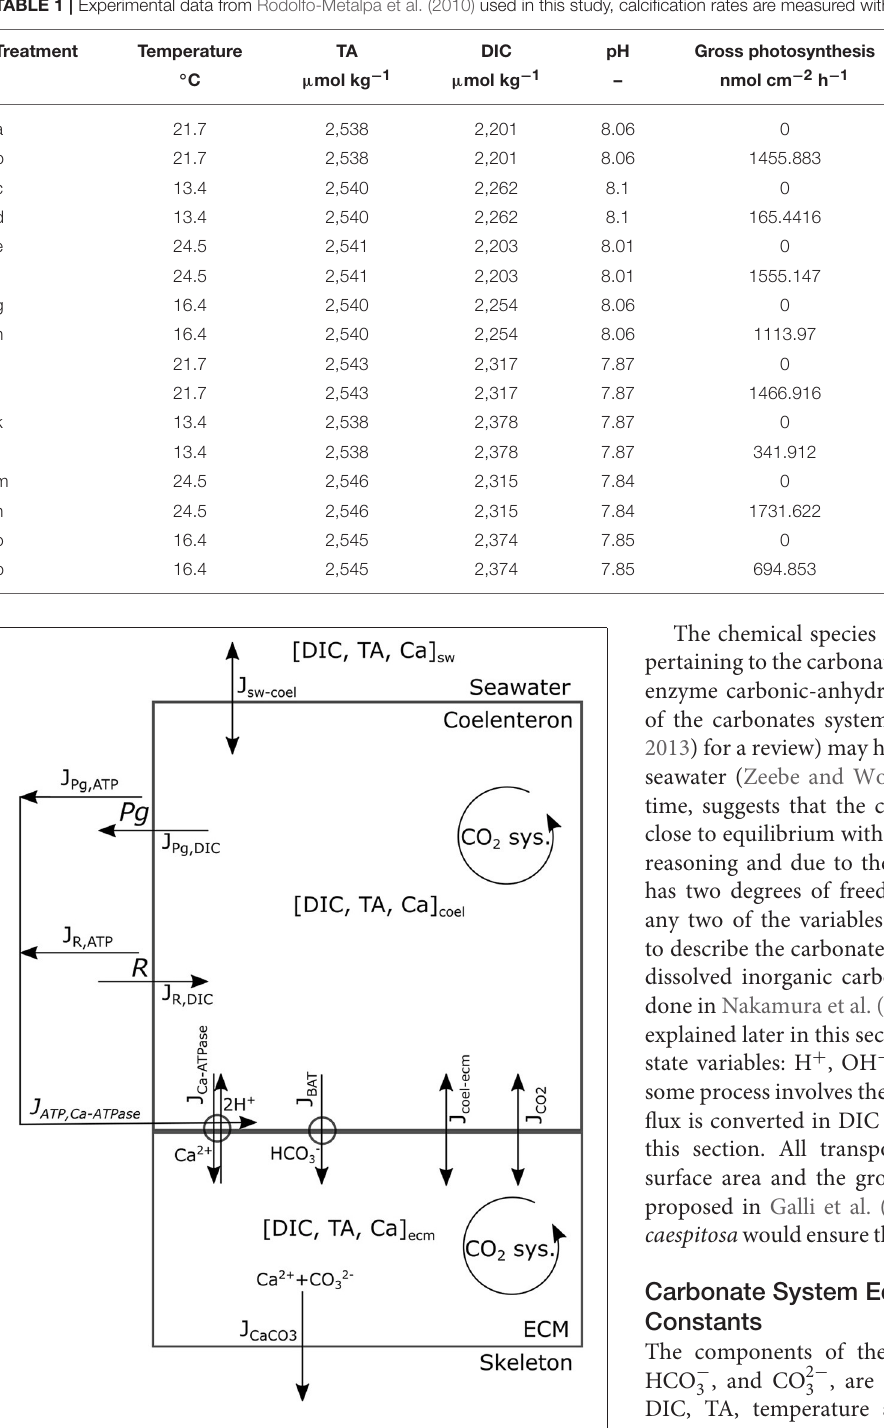
FIGURE 1 | Model’s conceptual scheme portraying compartments, main state variables, and fluxes.